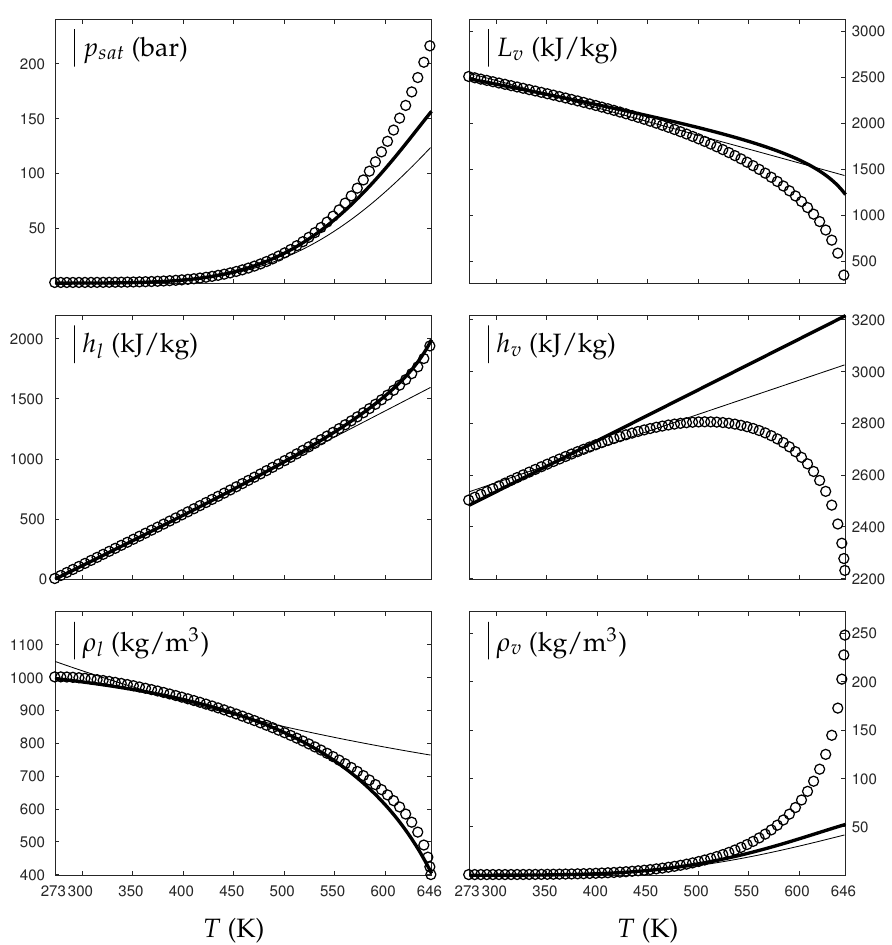
Figure 1. Comparison between experimental and theoretical saturation curves for liquid l and vapor v water. Symbols represent experimental data. The thick lines represent the theoretical saturation curves obtained with the Extended Noble–Abel Stiffened-Gas EOS (ENASG) reducing to the ideal gas description for the vapor phase, Equations (56) and (57). The thin lines represent results obtained with the original NASG EOS also reducing to the ideal gas formulation for the vapor phase. p sat denotes the saturation pressure, L v the latent heat, h the specific enthalpy and ρ the density.